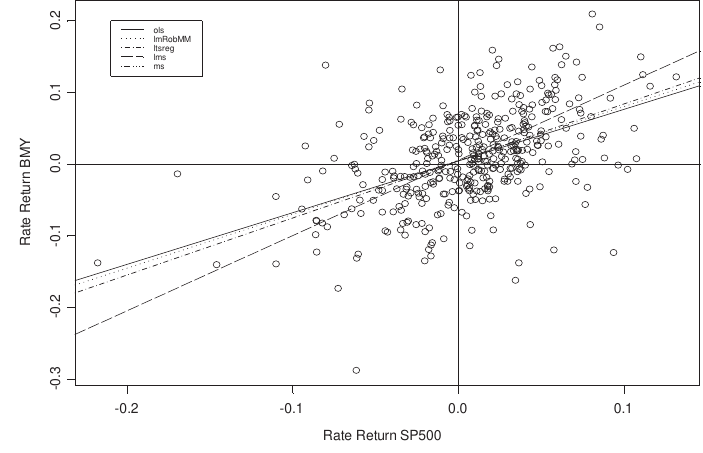
Fig. 1. Rate return BMY v rate return SP500